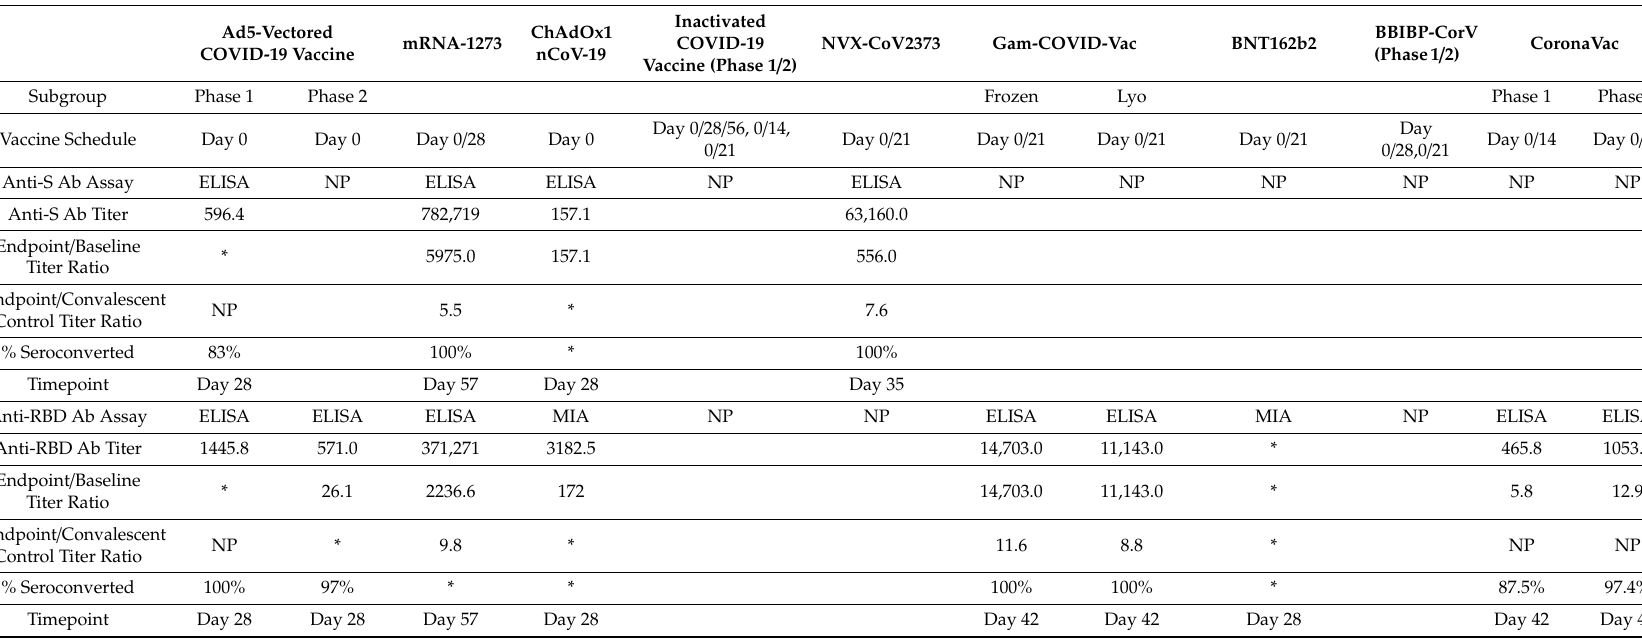
Table 3. Immunogenicity of vaccines as measured by antibodies against spike and the receptor binding domain.